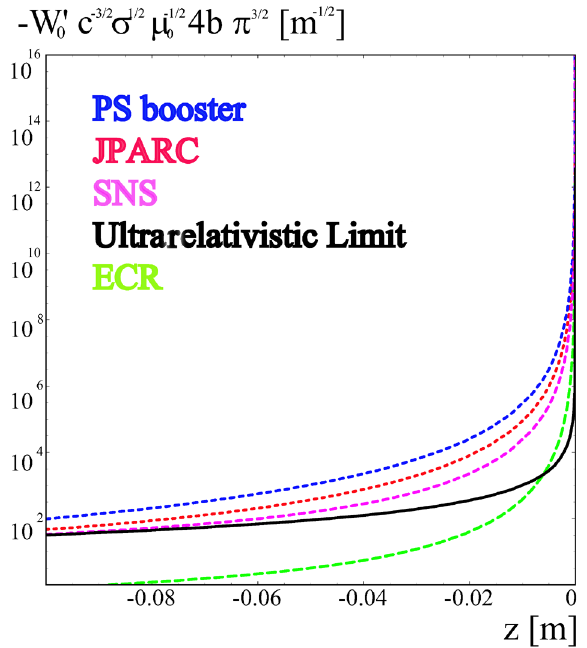
FIG. 1. (Color) Longitudinal wake j W 0 r (cid:7) 0 vs distance z in m , according to (64) (colored lines) for the examples of Table IV, and in the ultrarelativistic limit (65) (solid black line).